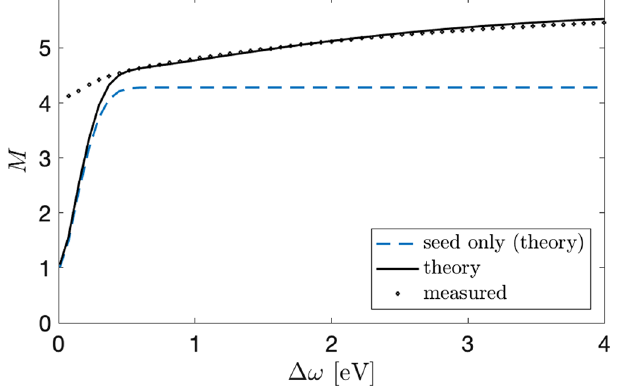
FIG. 7. Total measured number of modes versus bandwidth. The black line is calculated from the expression in Eq. (13), and the dotted line is directly from measured